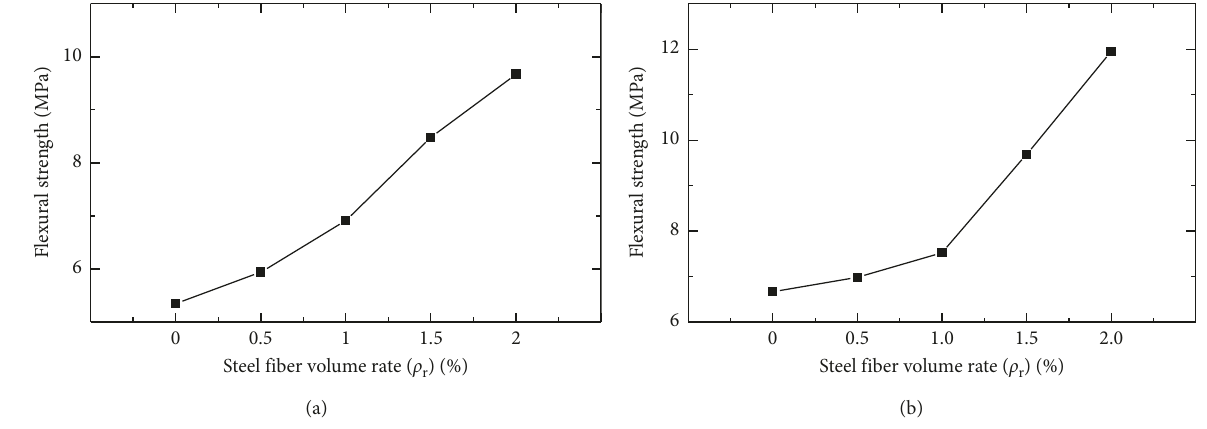
Figure 14: Relationship between flexural strength and steel fiber content. (a) CF50; (b)